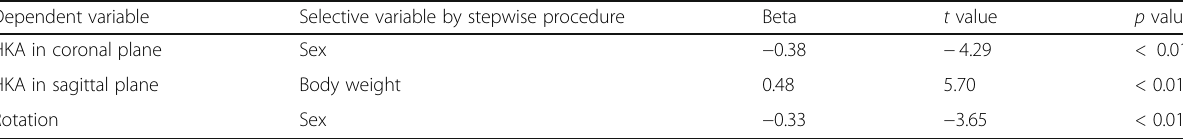
Table 3 Multiple linear regression analysis with dependent variable of alignment Dependent variable Selective variable by stepwise procedure